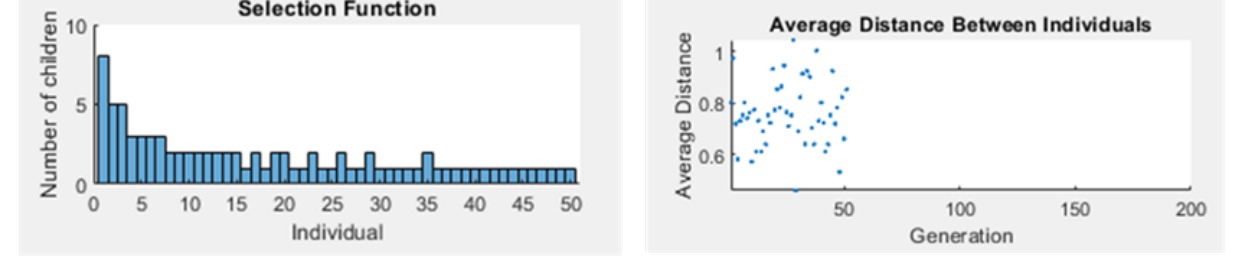
Figure 7. Genetic algorithm results. Table 2. Parameter